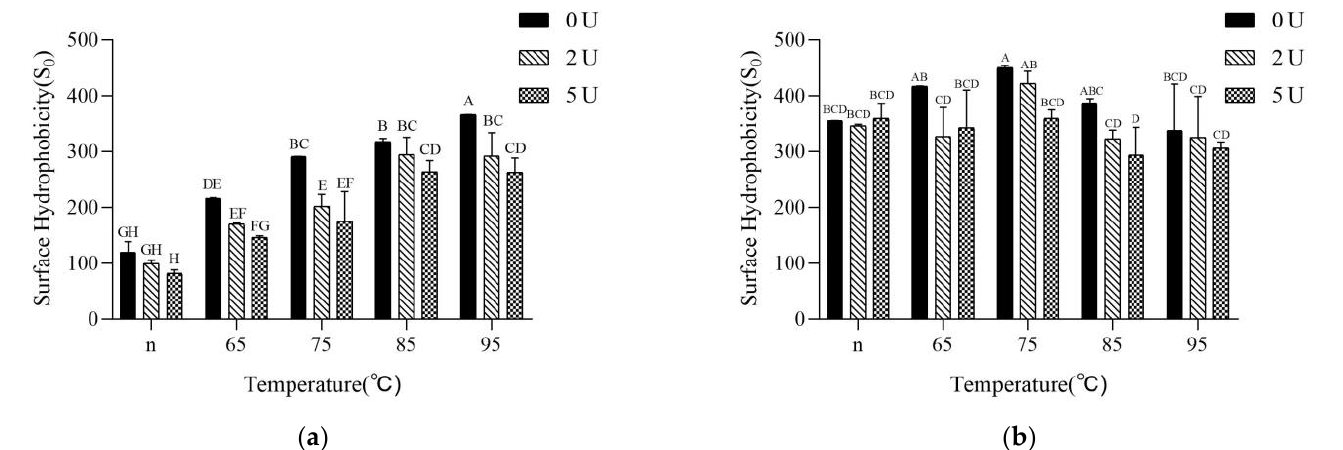
Figure 3. Surface hydrophobicity of the SPI samples. ( a ): before inactivating the PG; ( b ): after inactivating the PG. Different capital letters indicate significant differences ( p < 0.05).